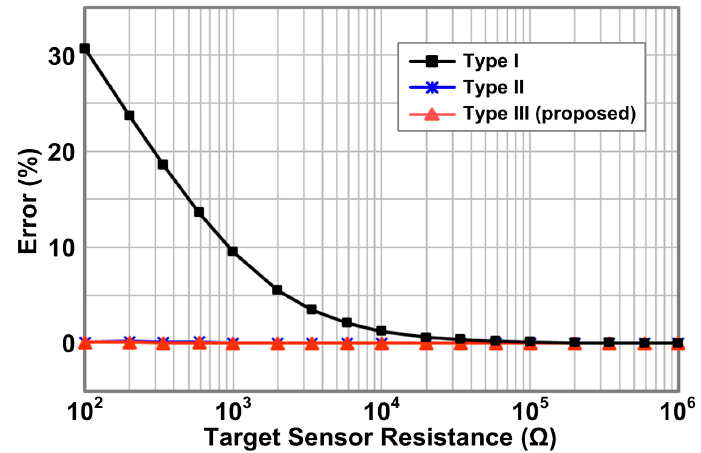
Figure 15. Measured output errors of three types of row driver circuits with 4 × 4 resistor array. Table 2. Performance comparison of row drivers.